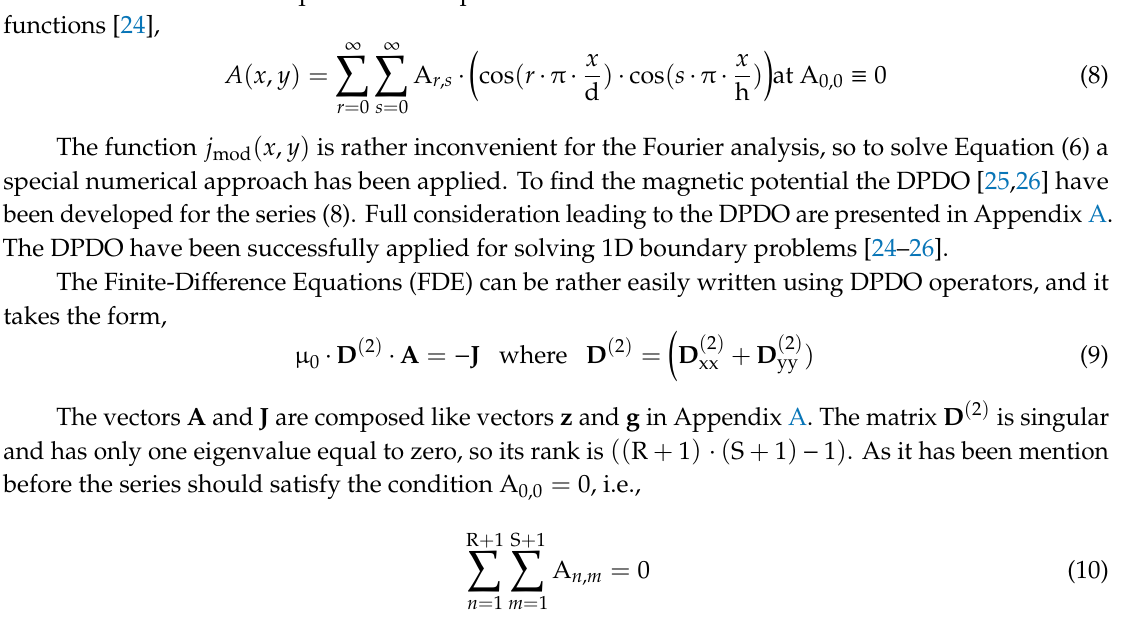
Figure 8. Ampere-turn function